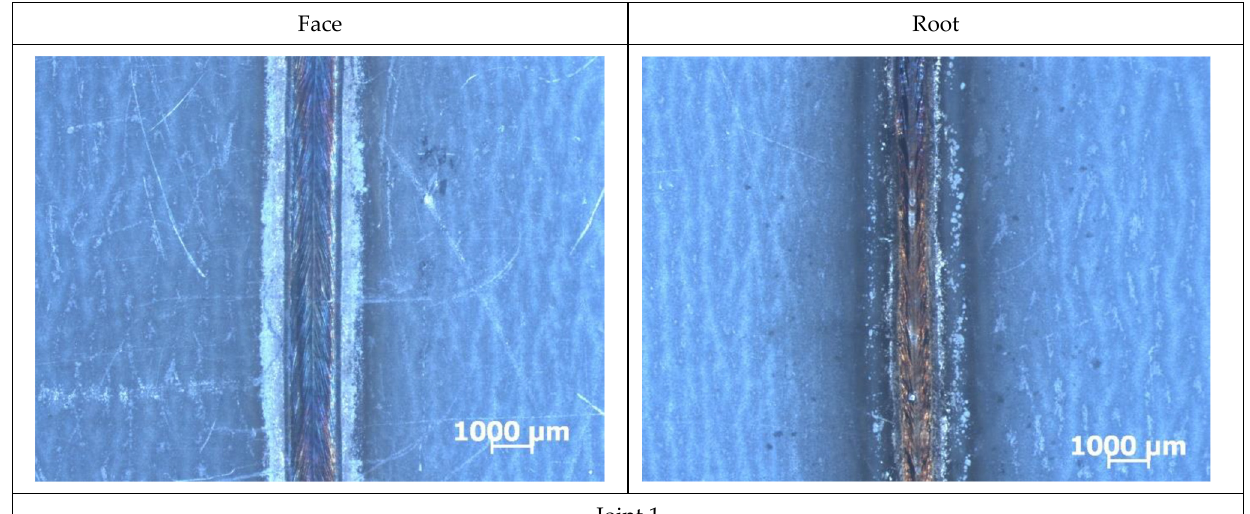
Table 2. Selected properties of DC04 steel in the tempered state.